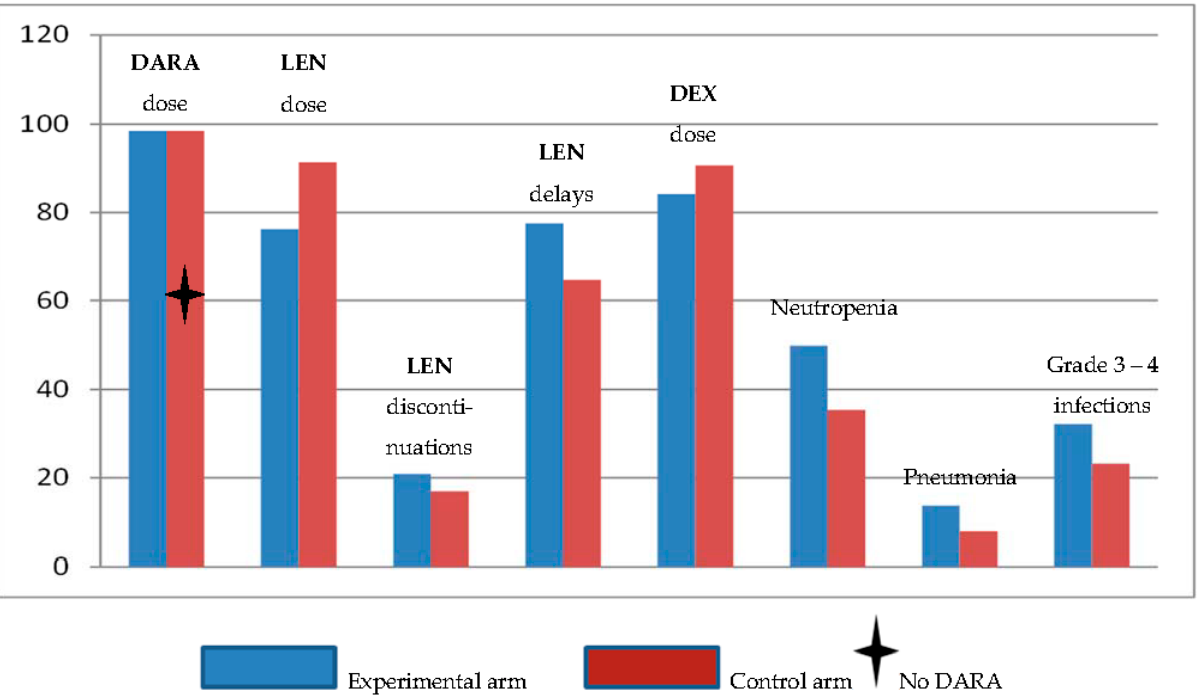
Figure 3. Dose intensity of Daratumumab, lenalidomide and dexamethasone, dose modifications of lenalidomide and adverse events in the MAIA trial [17].